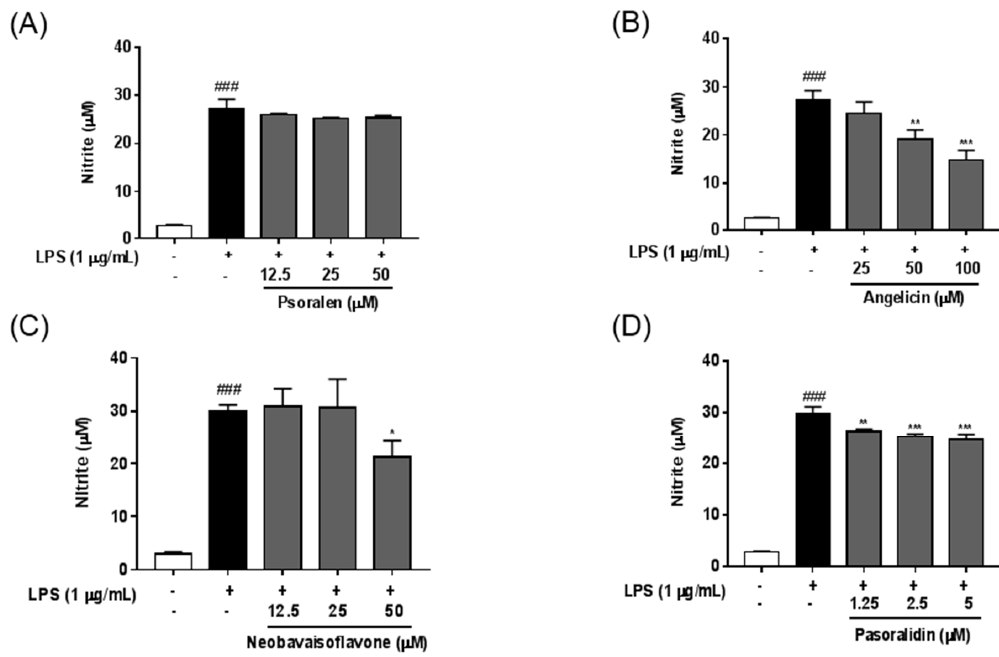
Figure 3. Cont. Figure 3.